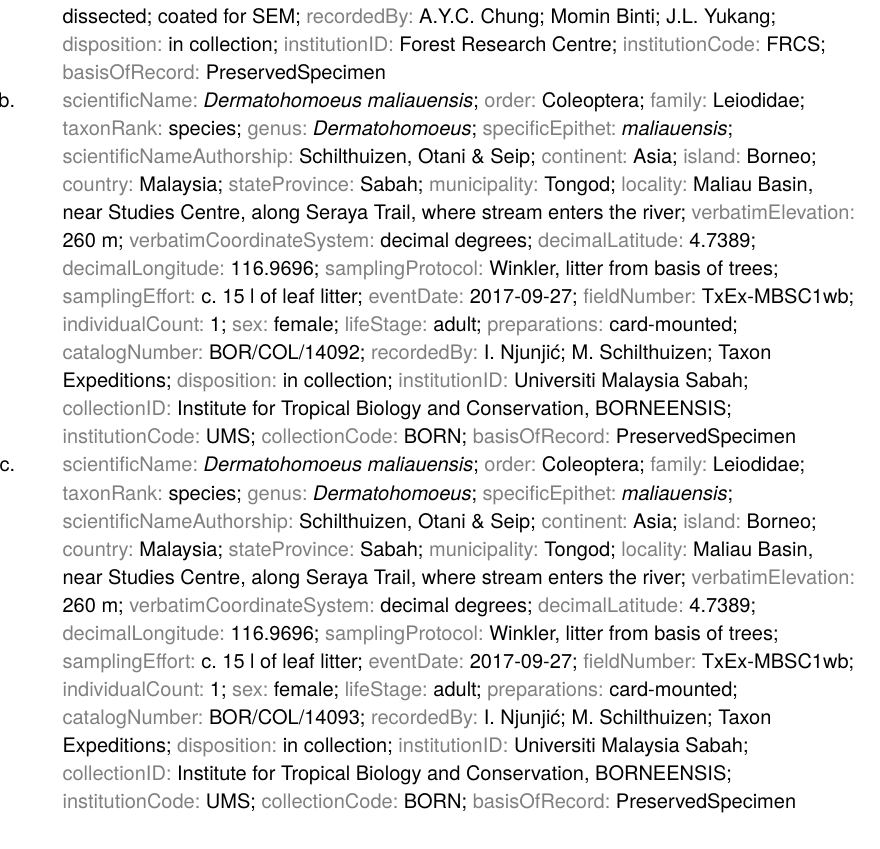
shoulders. Pronotum 2.0x wider than the head. Winged. Reddish brown, with yellow legs and antennae. Eyes large. Antennae slender, antennomere VII 1.5x as long as wide. Pronotal posterior angle not drawn out, only a very faint convex curve next to the rounded angles. Elytra sparsely pubescent, with distinct punctuation, here and there arranged into longitudinal rows. All punctures on the elytra connected by microreticulation. Head : Eyes large, each with an estimated 40-50 ommatidia. Ratio of horizontal width of eye (measured in dorsal view and perpendicular to the longitudinal axis of the head) to distance between eyes: 1:4.4. A thin supraorbicular groove runs along the inner margin of the eyes and over the antennal insertion. Length of antennomere III 0.7 times the length of antennomere II. Antennomere IX slightly narrower than antennomere X. Antennomeres X and XI of equal width (Fig. 9). Punctuation (when viewed at 50x magni fi cation) distinct, individual punctures spaced by 3-5 times their diameter (Fig. 7a). No microreticulation